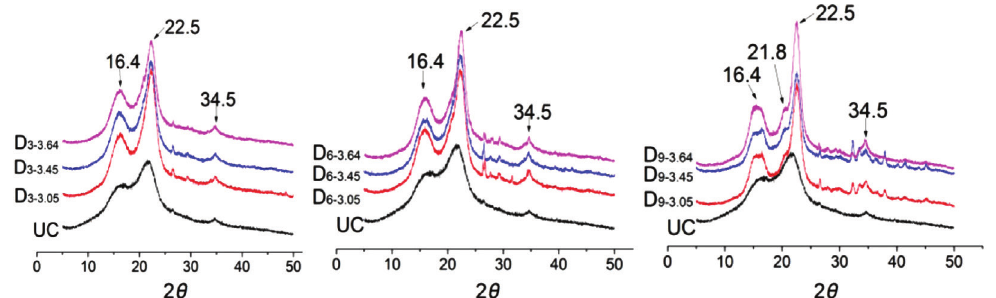
Fig. 3 – WAXS patterns of the delignified samples DC